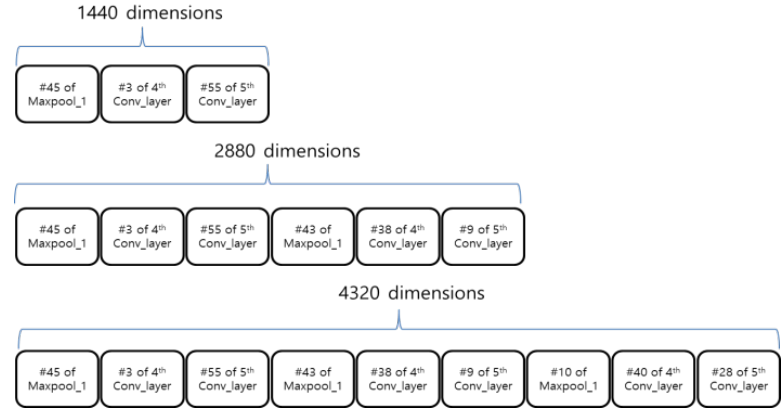
Figure 11. Feature sets used in the experiment.